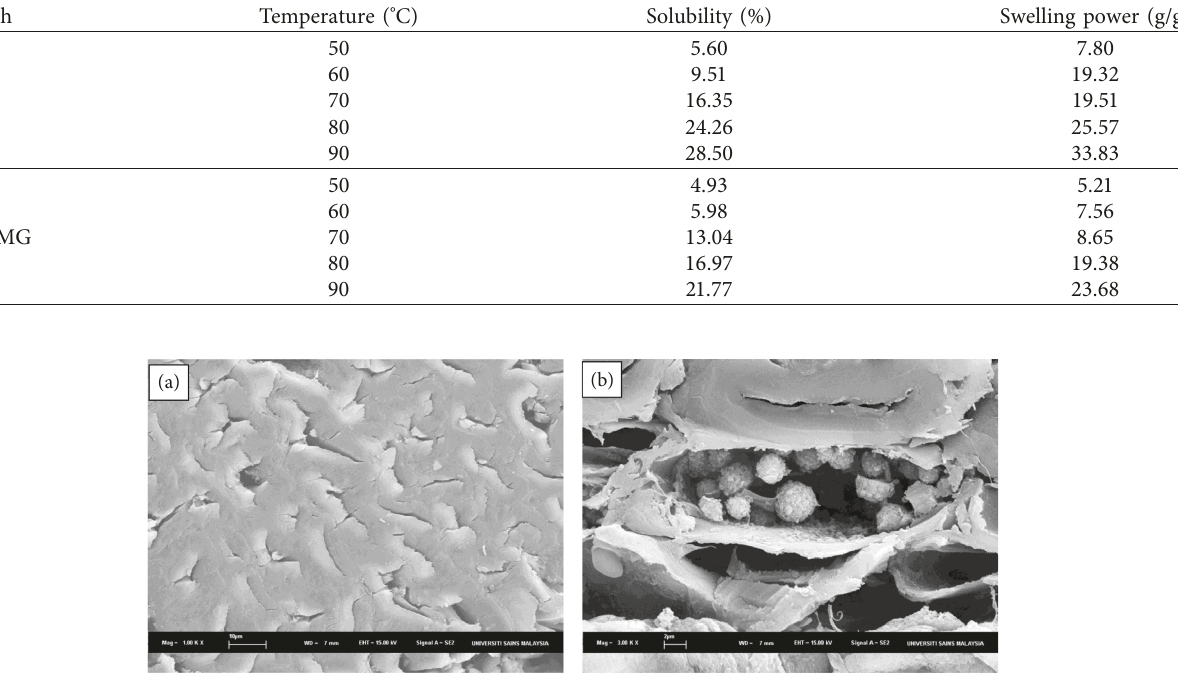
Figure 1: SEM image of wood composite made using oil palm starch modified with glutardialdehyde at 1000x (a) and 3000x (b) magnification.